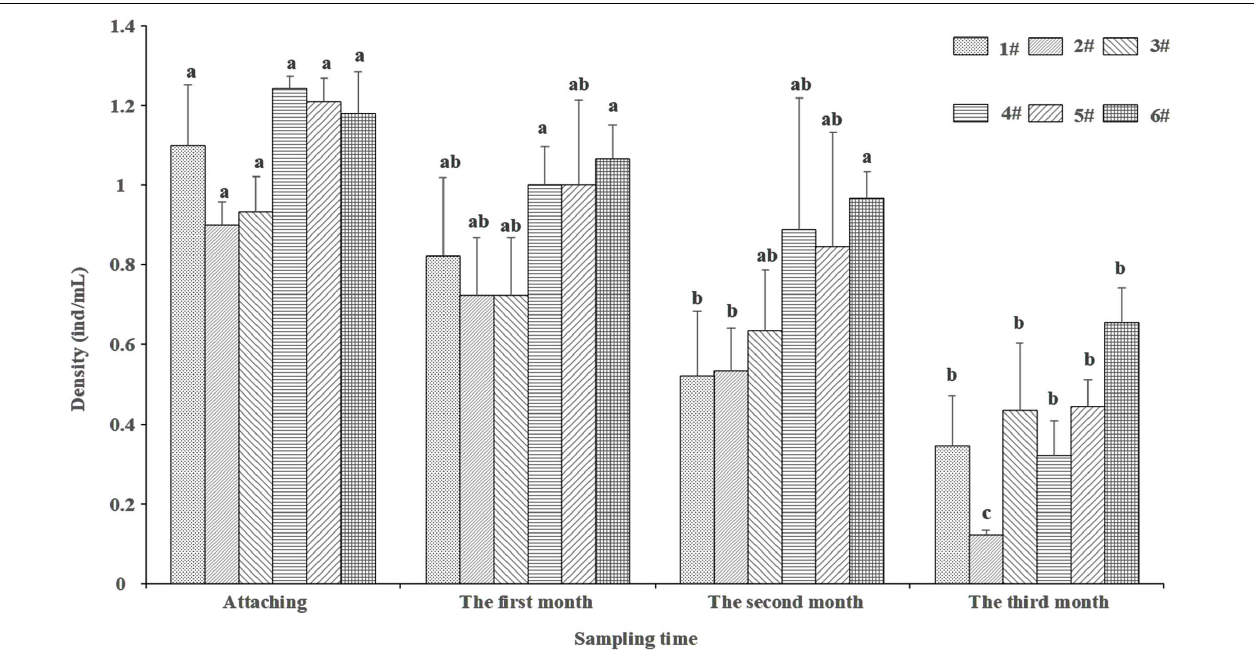
FIGURE 4 | Density of P. aibuhitensis larvae at different sampling time in different sediments. Data with different letters were significantly different in the same sediment. Error bars represent 1